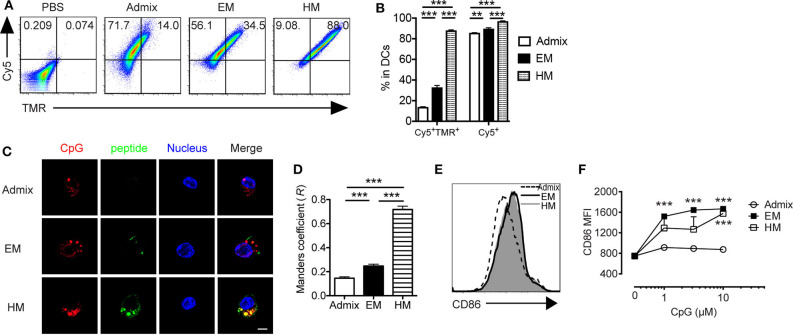
IS-SNAs facilitate DC uptake and activation in vitro. BMDCs were incubated with 5-TAMRA (TMR) labeled PSA65−73 and Cy5 labeled CpG in the form of admix, EM SNA, or HM IS-SNAs for 1 h. Uptake of IS-SNAs by BMDCs was monitored using flow cytometry (A,B) or confocal microscopy (C,D), respectively. (A) Representative flow dot plots and (B) percentages of Cy5+TMR+, Cy5+ BMDCs receiving different formulations containing 50 nM CpG. (C) Confocal microscopy images of BMDCs. Scale bar, 5 μm. (D) Subcellular colocalization analysis of PSA65−73 and CpG in (C) using Manders coefficient (0.6 < R ≤ 1.0 indicates colocalization). (E,F) BMDC activation status was examined by expression of co-stimulatory molecule CD86 8 h after incubation. (E) Representative histograms for CD86 expression by BMDCs at 10 μM (by CpG). (F) Median fluorescent intensity (MFI) for CD86 by BMDCs treated with admix or IS-SNAs. Data are presented as mean ± SEM. **p < 0.01 and ***p < 0.001 analyzed by two-tailed unpaired Student's t-test.